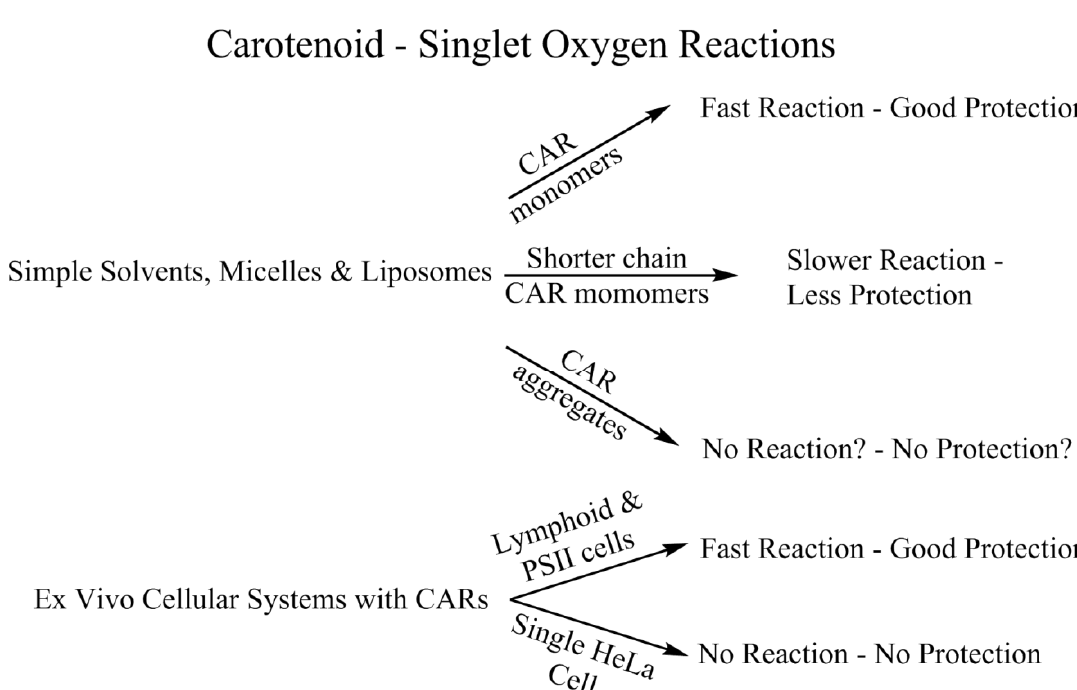
Figure 5. Summary scheme of carotenoid reactions with singlet oxygen .